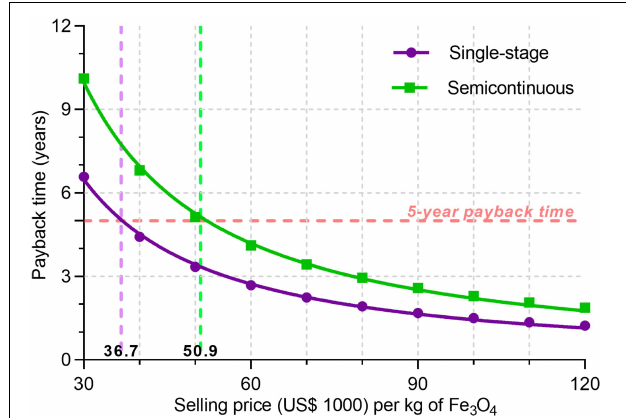
FIGURE 5 | Correlation between selling prices of BMNs and the investment payback time for each bioprocess. The salmon horizontal dashed line indicates the 5-year payback time limit for which MSPs are determined. Vertical dashed lines indicate MSPs for single-stage (purple line, US$ 36.7 thousand) and semicontinuous (green line, US$ 50.9 thousand)